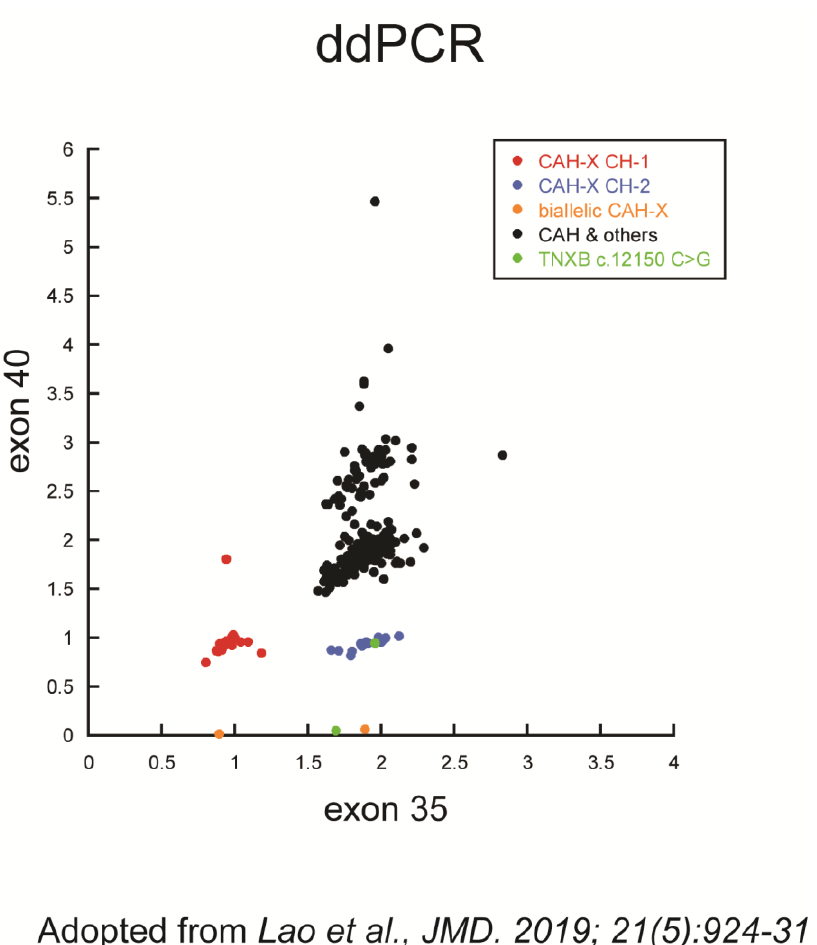
Figure 2. Identification of CAH-X chimeric type by droplet digital PCR (ddPCR). The copy numbers of TNXB exons 35 and 40 determined by ddPCR were used for the call of CAH-X chimeric genes.